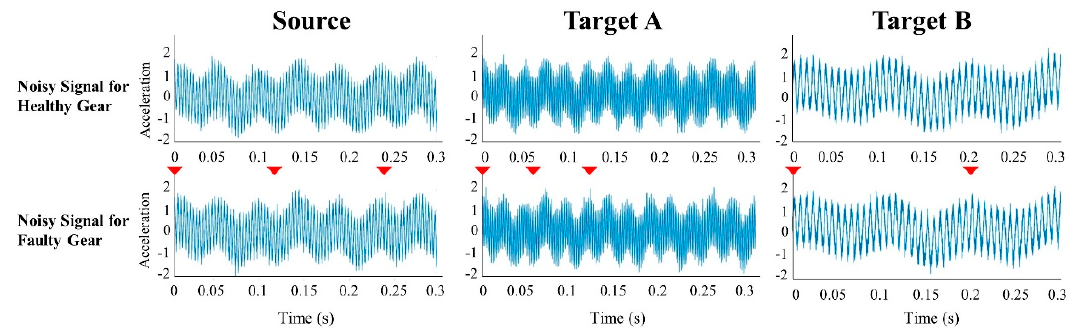
Figure 2. The vibration signal for each status in various operation conditions.